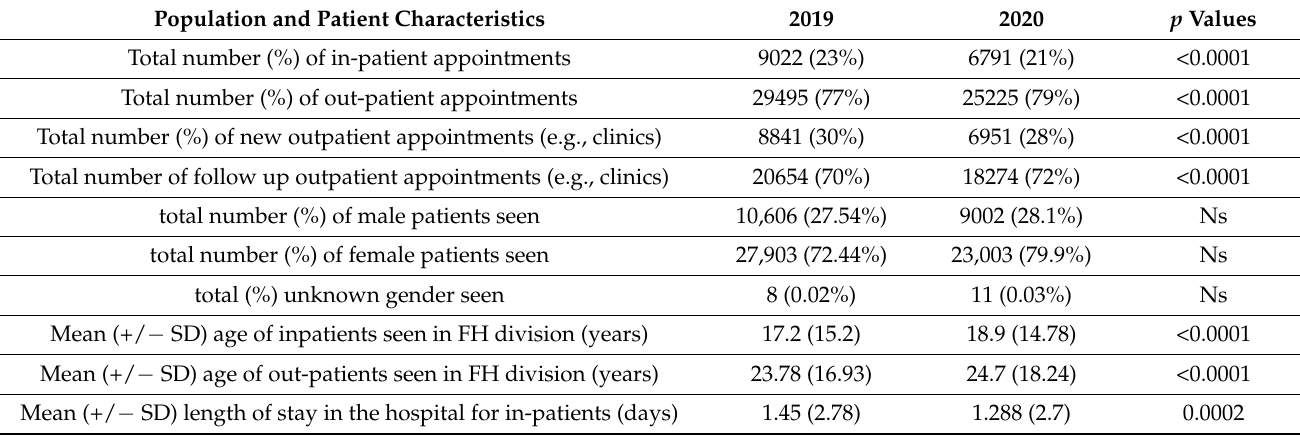
Table 3. Population and Patient Characteristics NUH Family Health division in 2019 compared with 2020. Population and Patient